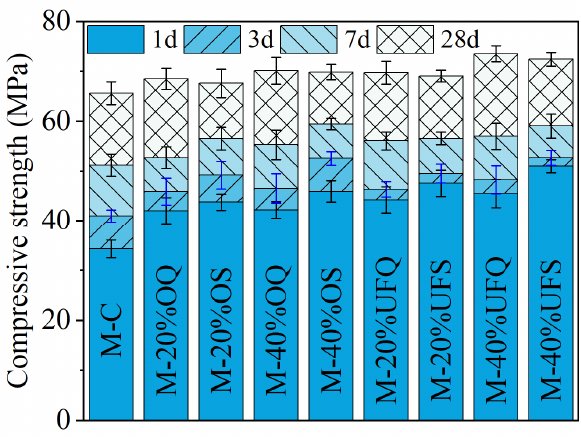
Figure 3. Compressive strengths of the MKPC